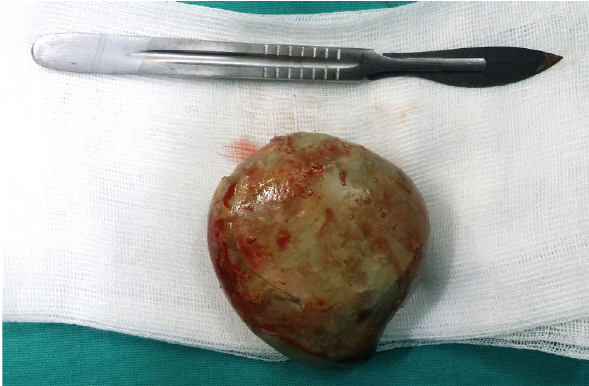
Figure 3: The calculi removed from the urethra.